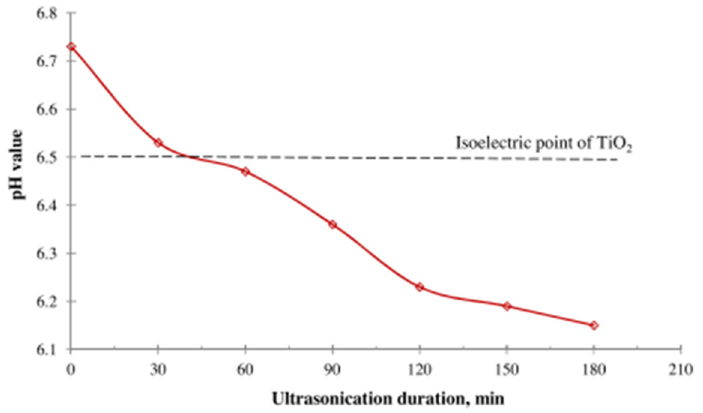
Figure 17. Influence of ultrasonication duration on pH value of TiO 2 –H 2 O NF with an isoelectric point of TiO 2 . Adapted from [124].